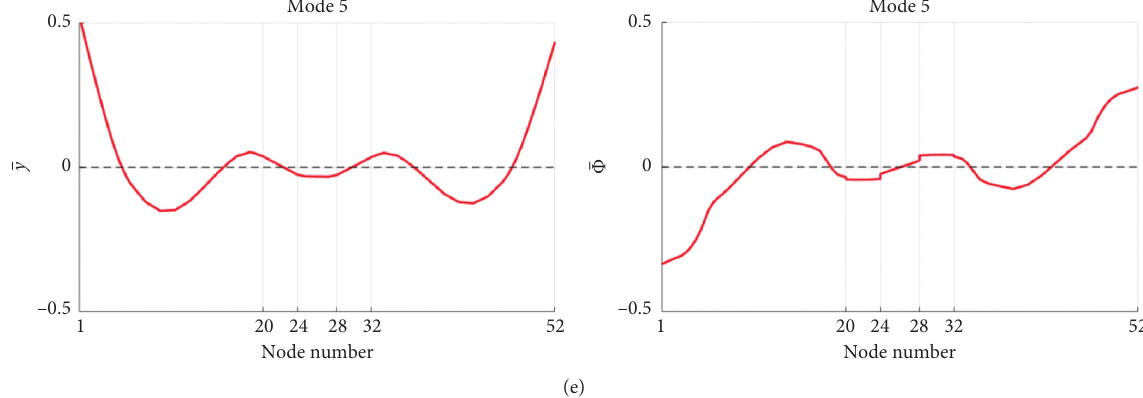
Figure 10: Normalized mode shape of the tie-bolt rotor: displacement y and rotational angle Φ .